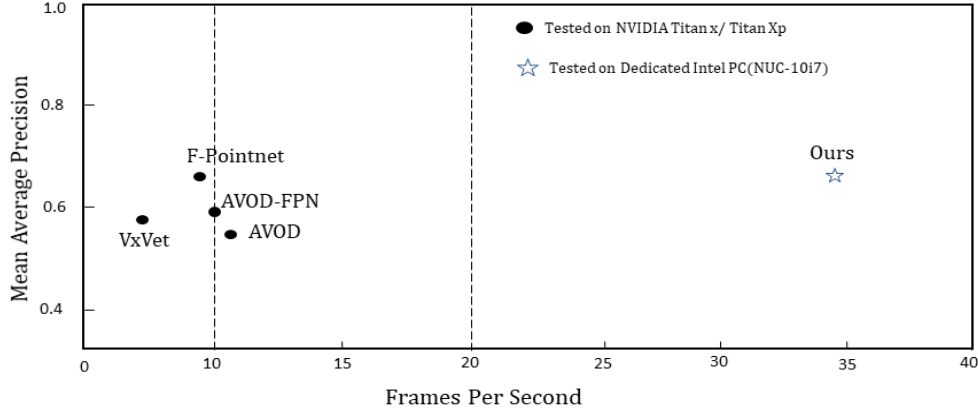
Figure 11. Performance comparison. This plot shows the mean average precision (mAP) against the run-time (FPS) in the LiDAR frame. We compare our proposed model with the existing model for 3D object detection and measured our architecture performance on a dedicated embedded platform (Intel PC) with real-time